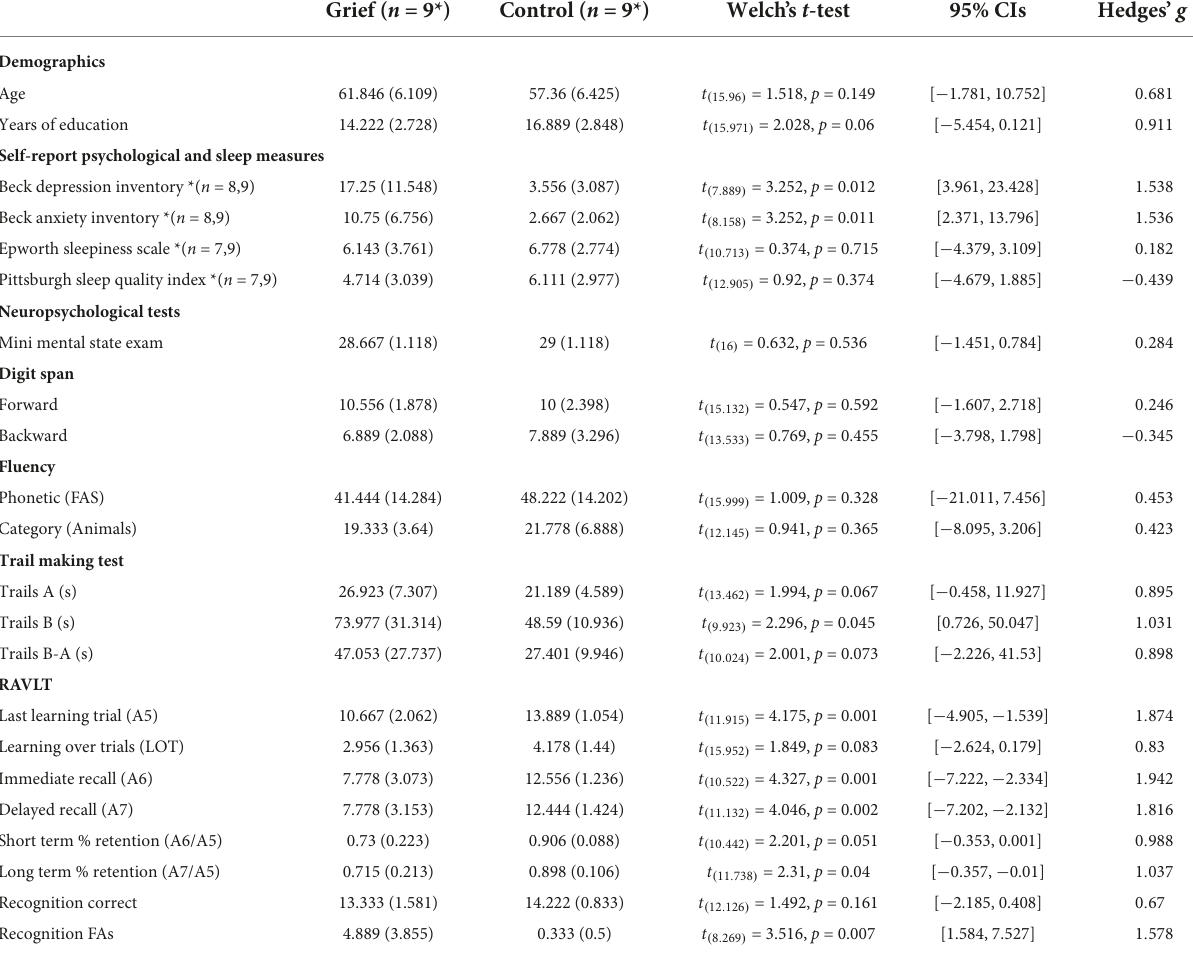
TABLE 1 Demographic, neuropsychological, and self-report